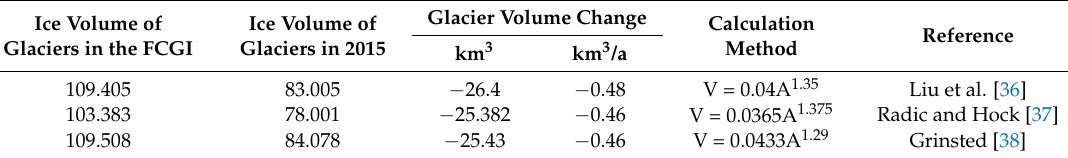
Table 4. Glacier volume changes based on three series of empirical parameters.